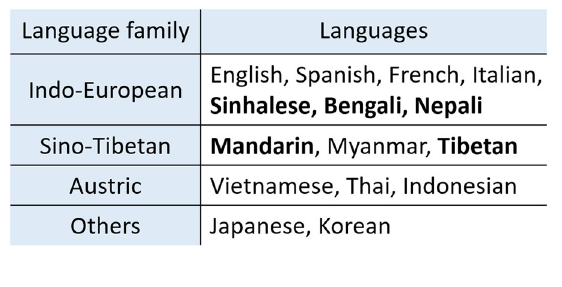
Fig. 4 A brief summary of language